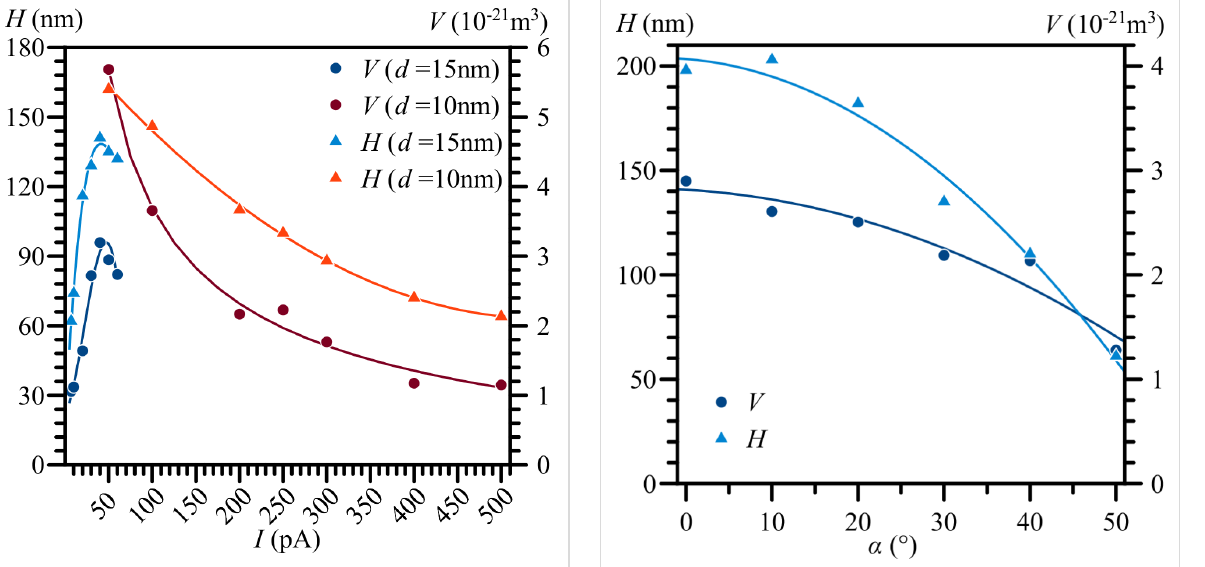
Figure 4: The volume and height of the nanostructures on an Ag sur- face as functions of the angle of incidence of the electron beam. Con- stant EB parameters are: U = 30 kV, I = 42 pA, d = 14 nm, and t = 60 s.